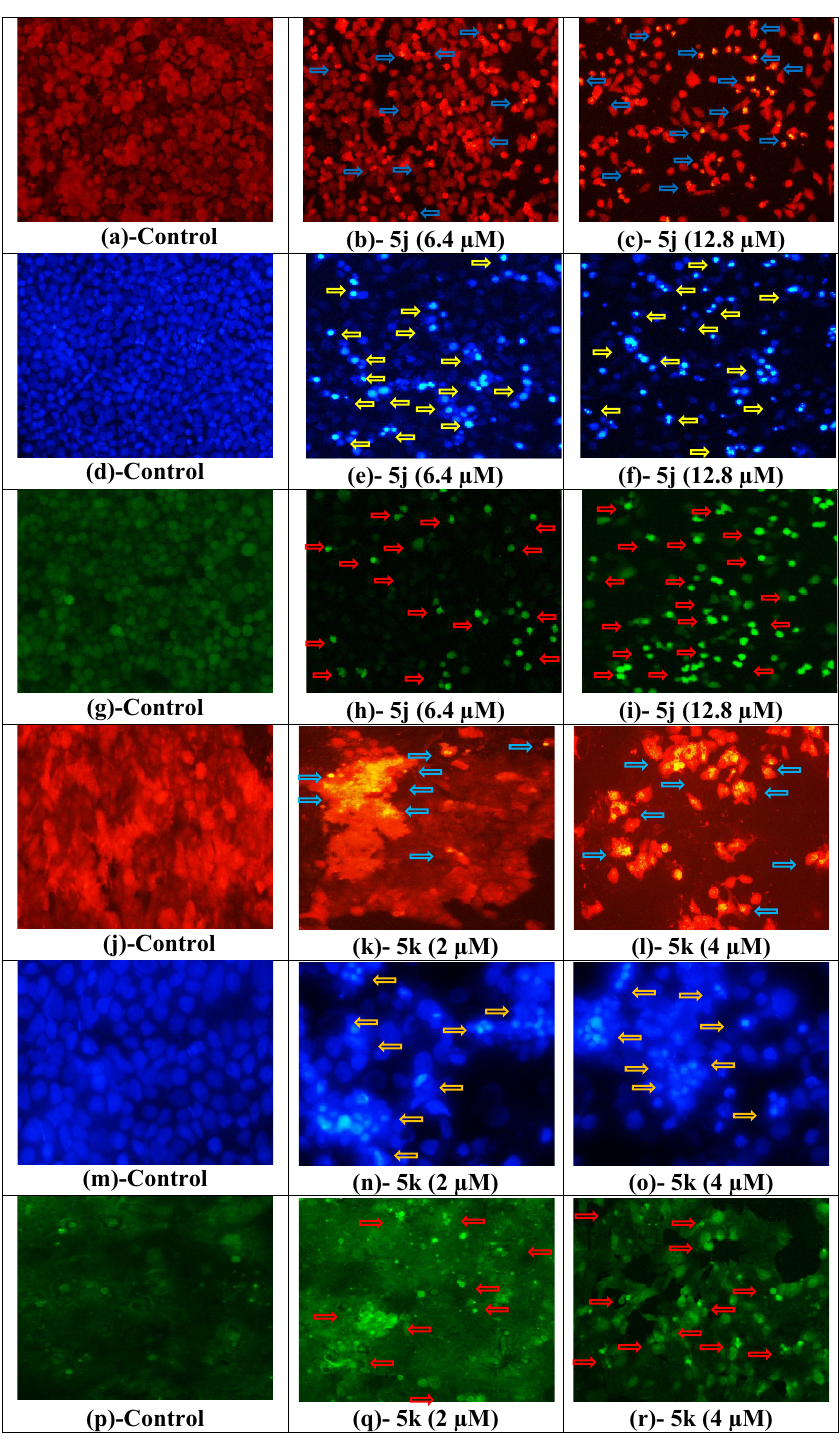
Figure 2. Fluorescence photomicrographs of untreated, compound 5j treated HeLa cells after PI ( a – c ), DAPI ( d – f ) and H 2 DCF-DA ( g – i ) staining and compound 5k treated MCF-7 cells after PI ( j – l ), DAPI (m,n,o) and H 2 DCF-DA ( p – r ) staining. Images are showing dose dependent cytotoxic, apoptotic and ROS generation indicated by arrows in compound 5j treated HeLa and 5k treated MCF-7 cells as compared to